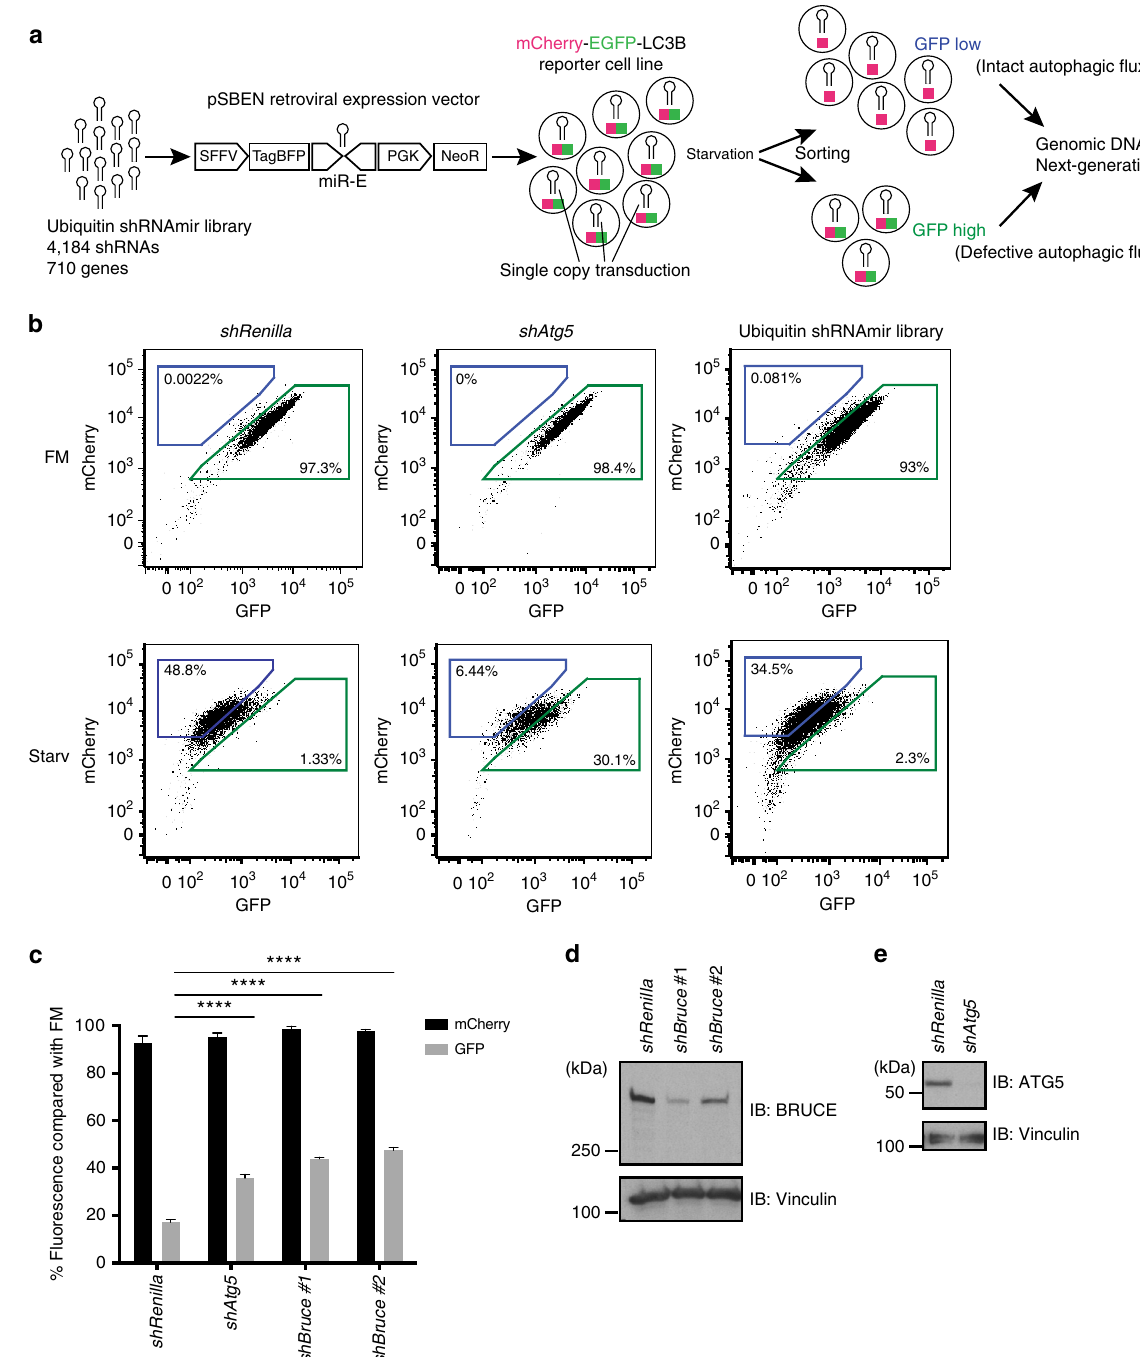
Fig. 1 shRNA-based screen identi fi es BRUCE as an autophagy regulator. a Schematic representation of the FACS-based screen using a library of short hairpin RNAs with the miR-E structure (shRNAmir). shRNAs (4,184) targeting 710 ubiquitin- and autophagy-associated genes were cloned into a retroviral gene expression vector (pSBEN). A single copy of shRNA was delivered into the mCherry-EGFP-LC3B-expressing MEF line (clone 1) by transduction. A cell population selected with neomycin was starved and sorted based on the GFP fl uorescent signal. Subsequently, genomic DNA was isolated from sorted cells and analyzed by next-generation sequencing. miR-E, microRNA-element 3 ’ backbone; NeoR, Neo reporter gene cassette; PGK, phosphoglycerate kinase; SFFV, spleen focus-forming virus; TagBFP, monomeric blue fl uorescent protein. b Gating strategy of “ GFP low/high ” cell population of shRenilla and shAtg5 MEFs, compared with ubiquitin shRNAmir library transduced cells (replicate #1). After 6 h starvation, cells were enriched in “ GFP low ” gate (blue) and depleted in “ GFP high ” gate (green). Percentage of cells in corresponding gates is indicated. c Relative mCherry and GFP signals compared with basal condition (fully supplemented medium (FM)) analyzed by fl ow cytometry. Control ( shRenilla (Renilla.713)), two BRUCE knockdown (KD) ( shBruce #1 (Birc6.766.), and #2 (Birc6.14744)) and ATG5 KD ( shAtg5 (Atg5.1063)) MEF lines were analyzed. Data are presented as mean ± SD from three biological replicates (**** p < 0.0001). Representative data are shown from four independent experiments. d , e Knockdown ef fi ciency of BRUCE and ATG5 in shBruce #1 and #2, and shAtg5 MEFs, respectively, analyzed by immunoblotting using anti-BRUCE and anti-ATG5 antibodies. Anti-Vinculin antibody